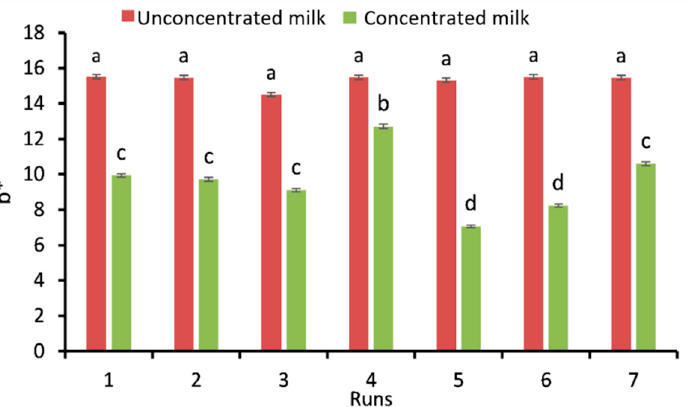
Figure 4. a* value of unconcentrated and concentrated milk. Different letters refer to significant differences between means.